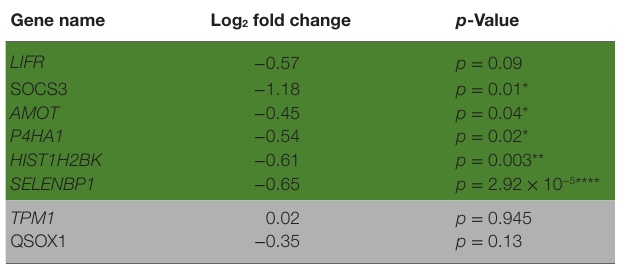
TaBle 1 | Cyclic AMP (cAMP) signaling is not induced by parathyroid hormone-related protein (PTHrP) in MCF7 cells. gene name